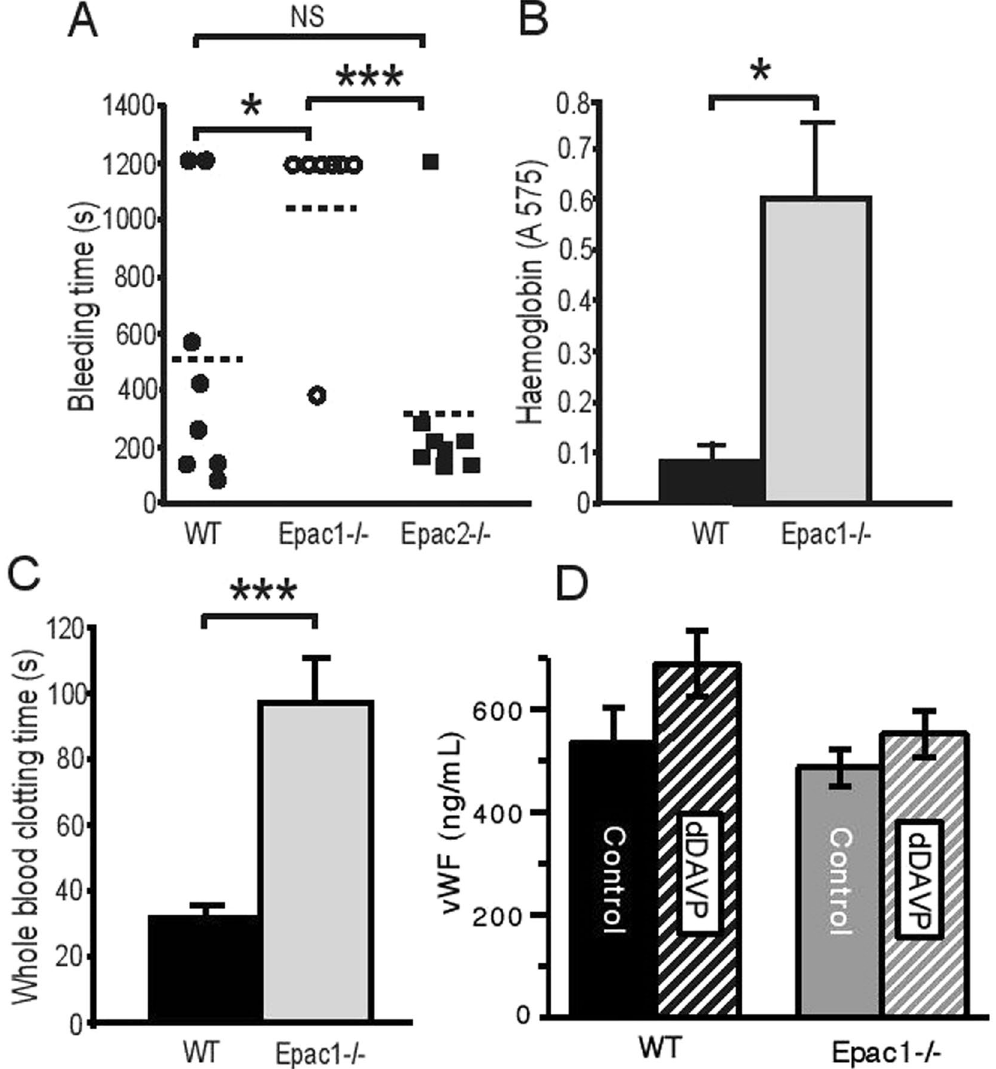
Figure 1. Epac1 − / − mice have increased bleeding time. ( A ) Tail bleeding time in WT (n = 8), Epac1 − / − (n = 7) and Epac2 − / − (n = 8) mice. Each point represents the measurement from one mouse. The horizontal dotted lines represent average tail bleeding time. 1200 seconds marks the experimental end point. ( B ) Blood loss quantified as amount of hemoglobin (absorbance at 575 nm) released during the tail bleeding test in WT (n = 8) and Epac1 − / − mice (n = 7). ( C ) Whole blood clotting time in WT (n = 6) and Epac1 − / − (n = 7) mice. ( D ) The plasma levels of vWF, determined by ELISA, 1.5 h after i.p. injection of 0.9% NaCl in WT (n = 4) and Epac1 − / − mice (n = 5), or of dDAVP (1ng/g bodyweight) in WT (n = 4) and Epac1 − / − mice (n = 5). The values shown are mean + / − SEM. NS = not significant, * P < 0.05, *** P < 0.005 ANOVA (A) and Student’s t-test (B, C,